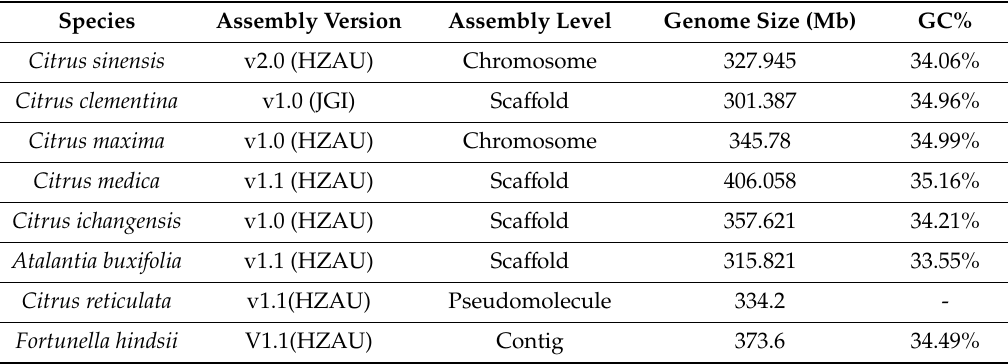
Table 1. The genomic data of di ff erent Citrus species used in the